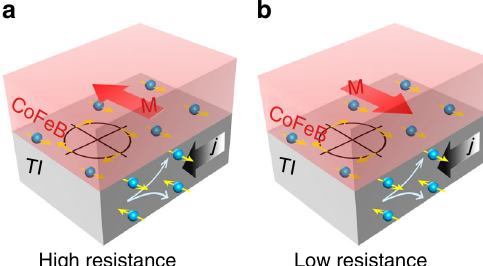
Fig. 1 Illustration of USRMR in TI/FM bilayer. Spin accumulation is generated at the interface and in the bulk when a charge current is applied. The relative direction of the spin polarization to the magnetization of either a parallel and b anti-parallel results in different resistance